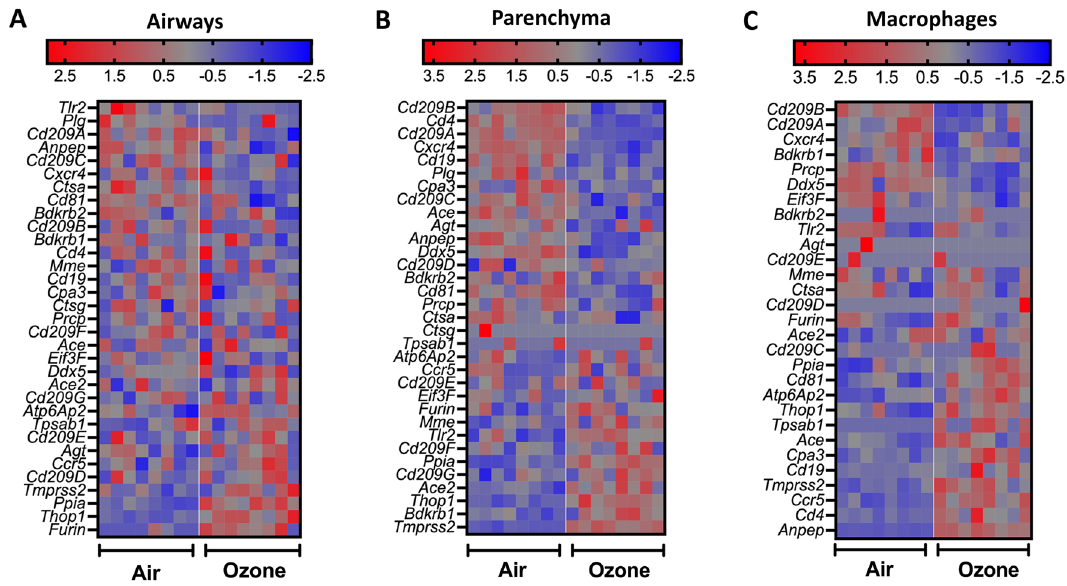
Figure 3. Heat maps depicting normalized gene expression values (Z-scores) of genes associated with SARS- CoV-2 host susceptibility in airways ( A ), parenchyma ( B ), and alveolar macrophages ( C ) from air- and ozone- exposed